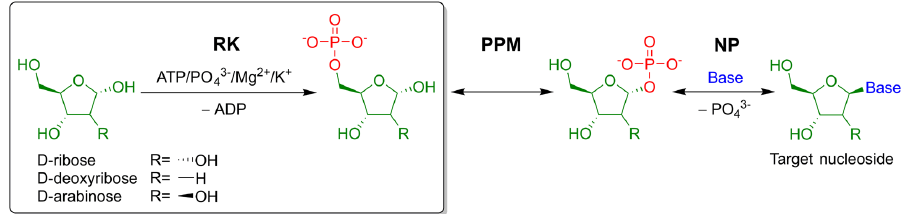
Figure 1. A three-enzyme cascade for the synthesis of modified nucleosides. RK—ribokinase (ec:2.7.1.15), PPM—phosphopentomutase (ec: 5.4.2.7), NP—nucleoside phosphorylase, usually purine nucleoside phosphorylase (ec:2.4.2.1). Base—nucleobase substrate/nucleoside moiety.